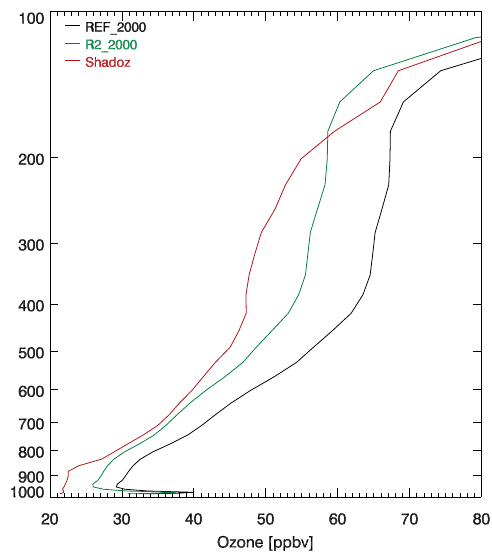
Fig. 6. A comparison of annual mean profiles from SHADOZ, with corresponding profiles from REF 2000 and R2